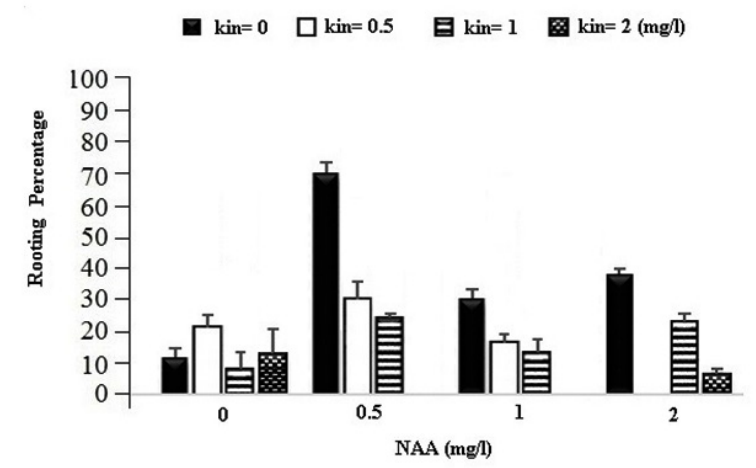
Fig. 2. The Effect of Different Concentrations of Growth Regulators (NAA) and Kinetin on the Rooting Percentage of Calli in